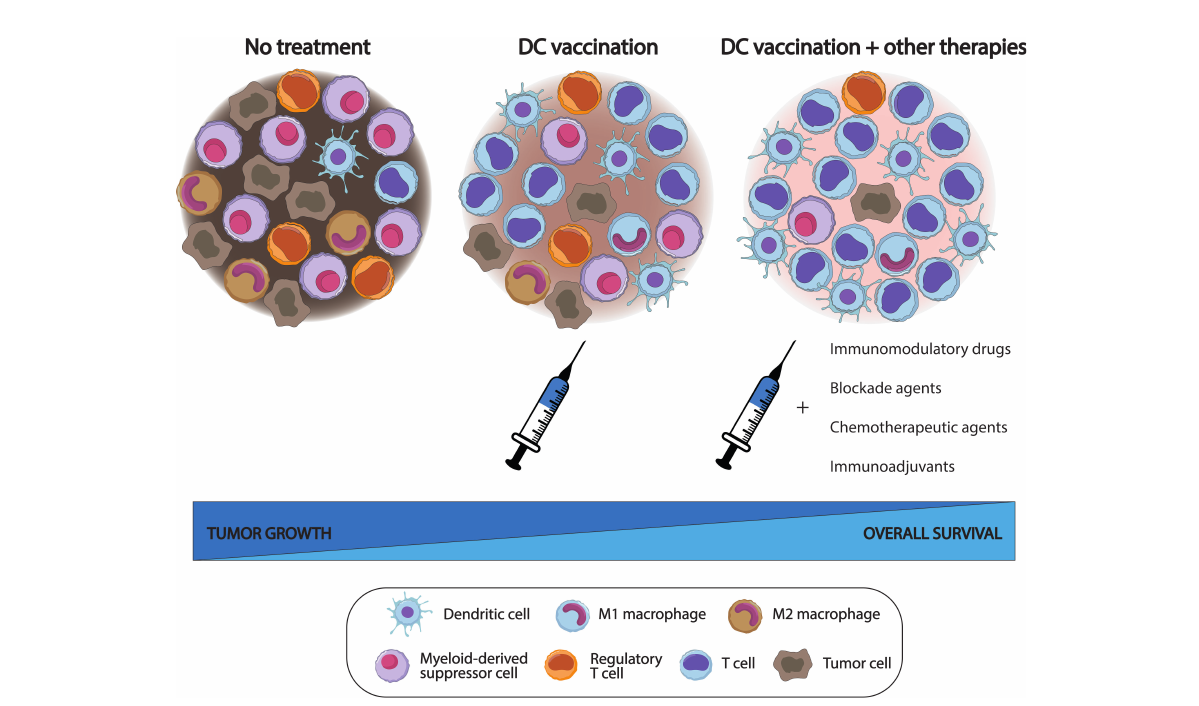
FIGURE 2 Effects of dendritic cell (DC) vaccination (alone and combined with other treatments) on the tumor microenvironment (TME) in comparison with a non-treated TME. DC vaccines exert a bene fi cial (although limited) function, increasing the number of lymphoid cell populations within the TME, but with variable levels of myeloid-derived suppressor cells (MDSC), compared with non-treated subjects. However, the addition of some drugs may synergistically potentiate the effects of DC vaccines to further delay tumor growth, improve survival rates, and signi fi cantly decrease the number of suppressor cell populations, including MDSC, within the